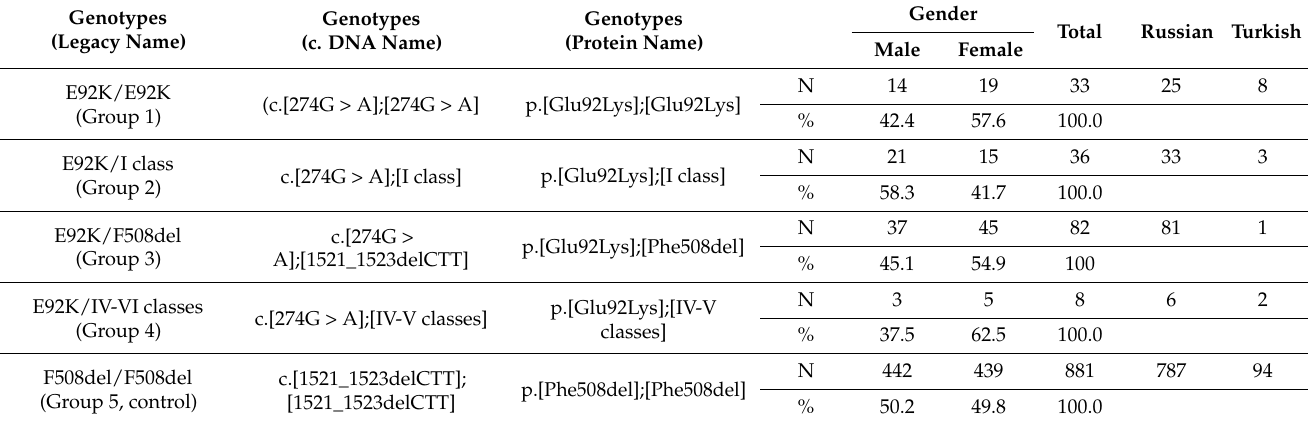
Table 3. Frequency of genotypes containing the E92K